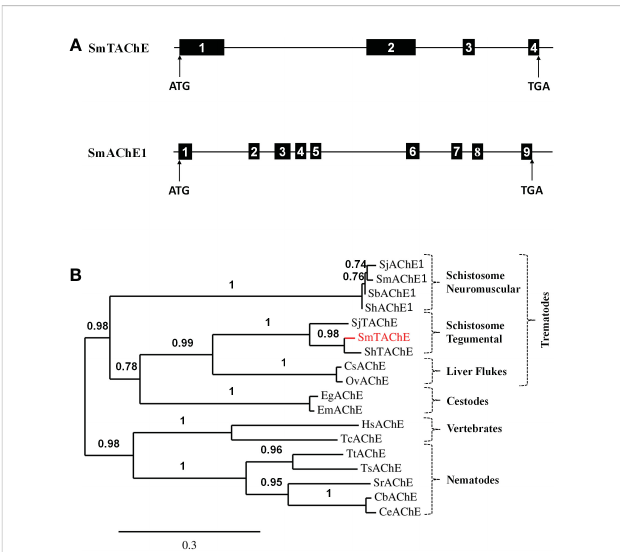
FIGURE 3 (A) Schematic representations of the SmTAChE (top) and SmAChE1 (bottom) genes. Black boxes represent the numbered exons and thin lines introns. The positions of the start (ATG) and stop (TGA) codons are noted. (B) Phylogenetic analysis of the following AChEs: S. mansoni SmTAChE, (Accession no: OP018961, red), S. haematobium ShTAChE, (OP018962), S. japonicum SjTAChE, (OP018963), S. mansoni SmAChE1, (AAQ14321.1 ), S. haematobium ShAChE1, (AAQ14322.1), S. bovis SbAChE1, (AAQ14323.1), S. japonicum SjAChE1, (ANH56887.1), Echinococcus granulosus EgAChE, (EUB57267.1) Echinococcus multilocularis EmAChE, (CDS43027.1), Clonorchis sinensis CsAChE, (GAA53463.1), Opisthorchis viverrini OvAChE, (XP_009168237.1), Caenorhabditis briggsae CbAChE, (XP_002643631.1), Caenorhabditis elegans CeAChE, (NP_510660.1), Trichuris trichiura TtAChE, (CDW55373.1), Trichinella spiralis TsAChE, (XP_003374589.1), Strongyloides ratti SrAChE, (CEF63281.1), Homo sapiens HsAChE, (NP_000656) and the electric eel Torpedo californica TcAChE, (P04058.2). Numbers on the branches re fl ect the branch support value, and the scale bar indicates 30% amino acid sequence